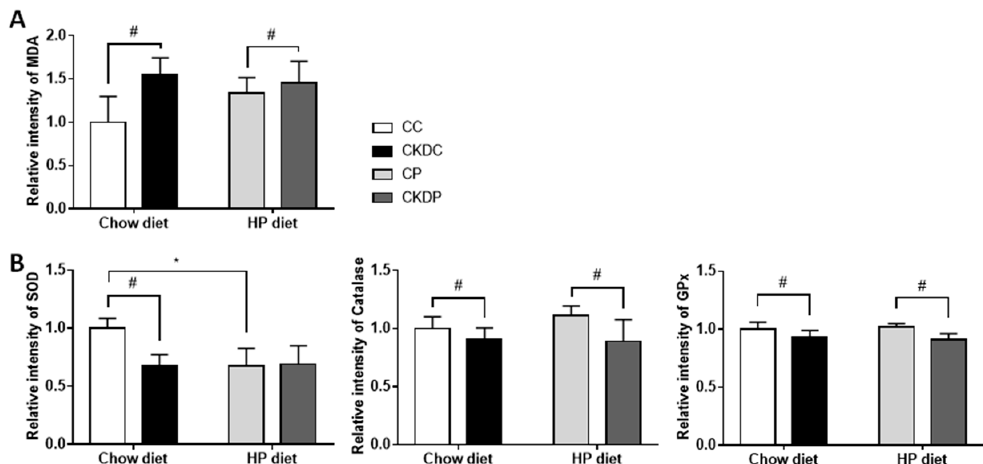
Figure 5. Testicular oxidative stress biomarkers in high phosphorus diet-fed mice with or without CKD induction. ( A ) MDA level and ( B ) antioxidant activities (SOD, CAT and GPx). Data are expressed as the mean ± SD. # indicates a significant di ff erence between the sham-operated and CKD-induced groups (SC vs. CKDC and SP vs. CKDP); * indicates a significant di ff erence between the chow diet and high phosphorus diet groups (SC vs. SP and CKDC vs. CKDP). SOD, superoxide dismutase; CAT, catalase; GPx, glutathione peroxidase; MDA, malondialdehyde.